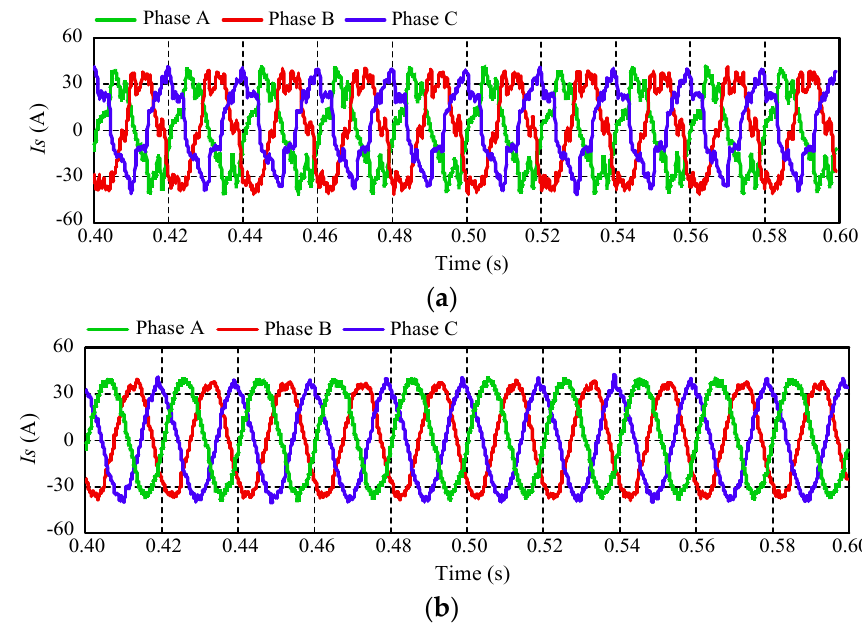
Figure 13. Simulation result about currents in the grid-winding of the new grid-connected transformer when wind farm’s output power is 4.5 MW. ( a ) No filtering; ( b ) With inductive filtering.